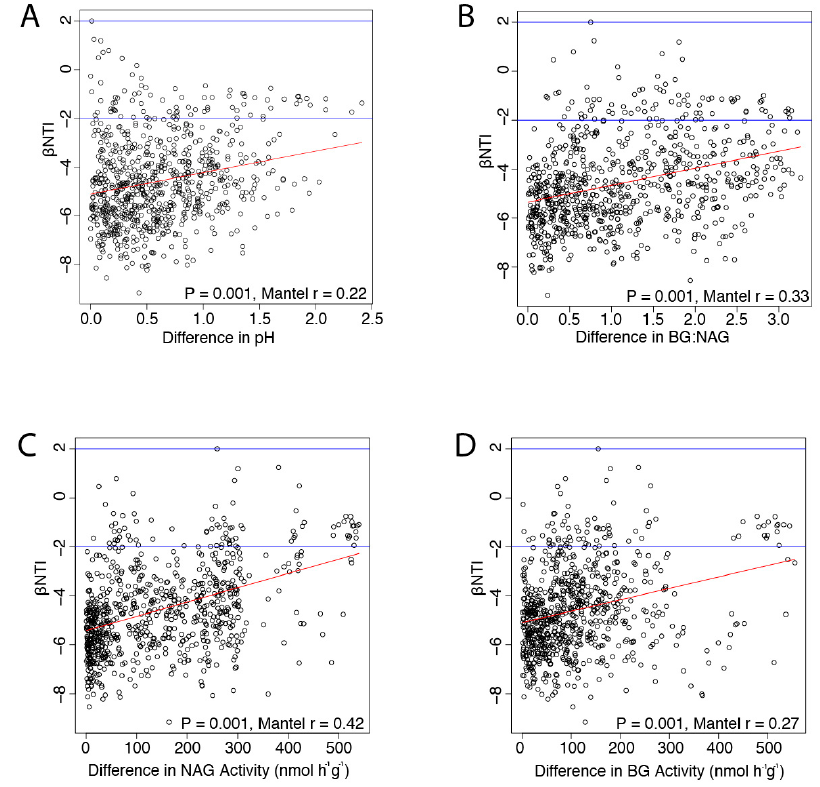
Figure 2. Changes in selective pressures correspond to soil pH and microbial enzyme activities. Ecological null models were used to infer pairwise di ff erences in selection across soil bacterial communities ( β NTI). β NTI values below -2 indicated homogeneous selective pressures between samples, while β NTI greater than 2 indicated statistically dissimilar selective pressures between two samples. Therefore, positive correlations between β NTI and di ff erences in soil or bacterial properties indicated that selective pressures diverged as these di ff erences increased. We found that di ff erences in ( A ) pH, ( B ) β -1,4-glucosidase (BG): β -1,4-N-acetylglucosaminidase (NAG), ( C ) NAG, and ( D ) BG across samples corresponded to increasingly di ff erent selective pressures, thereby linking edaphic properties, changes in ecological assembly processes, and microbial investment in carbon (C)- vs. nitrogen (N)-acquiring